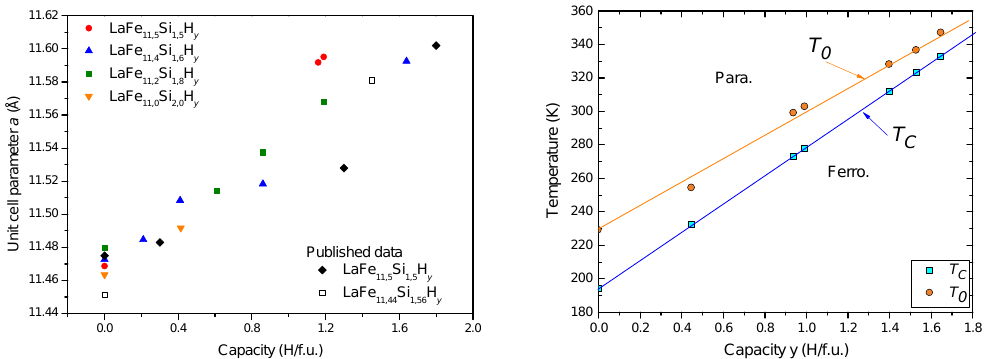
Figure 9. ( Left ) Unit cell parameter a vs. hydrogen content [66,67]. ( Right ) Magnetic phase diagram of LaFe 11.44 Si 1.56 H y . The IEM transition occurs between T 0 (the temperature at which the IEM transition disappears) and T C